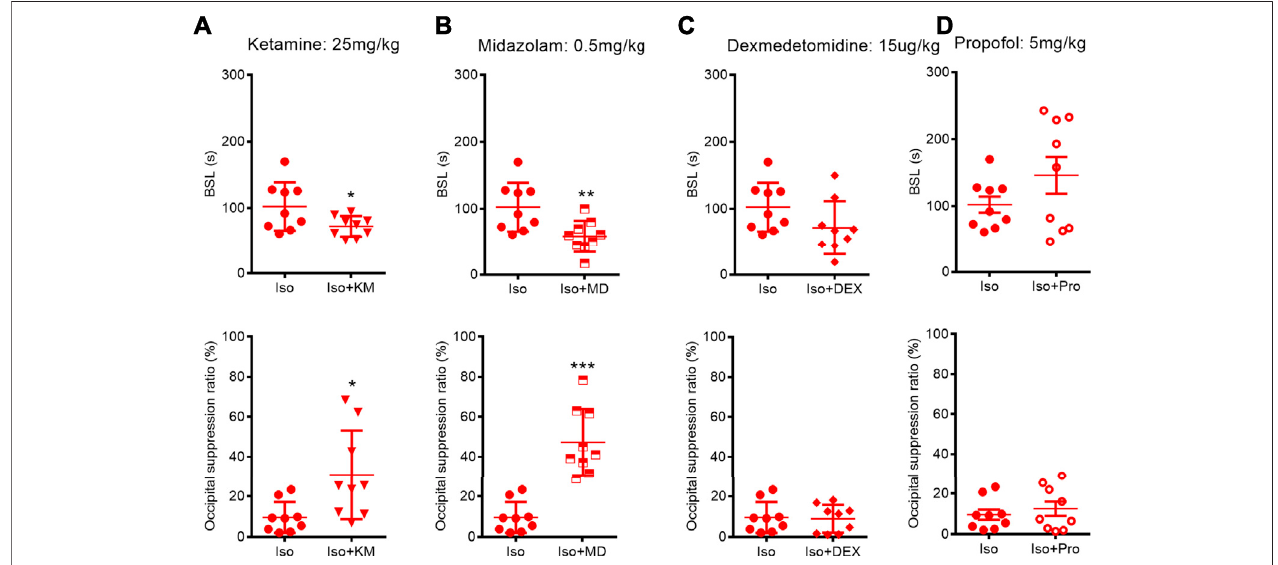
FIGURE 5 | Effects of co-administration anesthetics or adjuvant drugs on BSL and BSR during iso fl urane anesthesia. (A – B) Animals receiving ketamine or midazolamco-administrationshowedasigni fi cantdecreasedBSL( n (cid:1) 9)andincreasedBSR( n (cid:1) 9,respectively)duringiso fl uraneanesthesia. (C – D) Dexmedetomidine orpropofolco-administrationdidnotchangeneitherBSLnorBSRduringiso fl uraneanesthesia.Dataareexpressedasmean ± SD,Statisticalsigni fi cancewith *p < 0.05, **p < 0.01, ***p < 0.001. Iso, iso fl urane; KM, ketamine; MD, midazolam; DEX, dexmedetomidine; Pro,